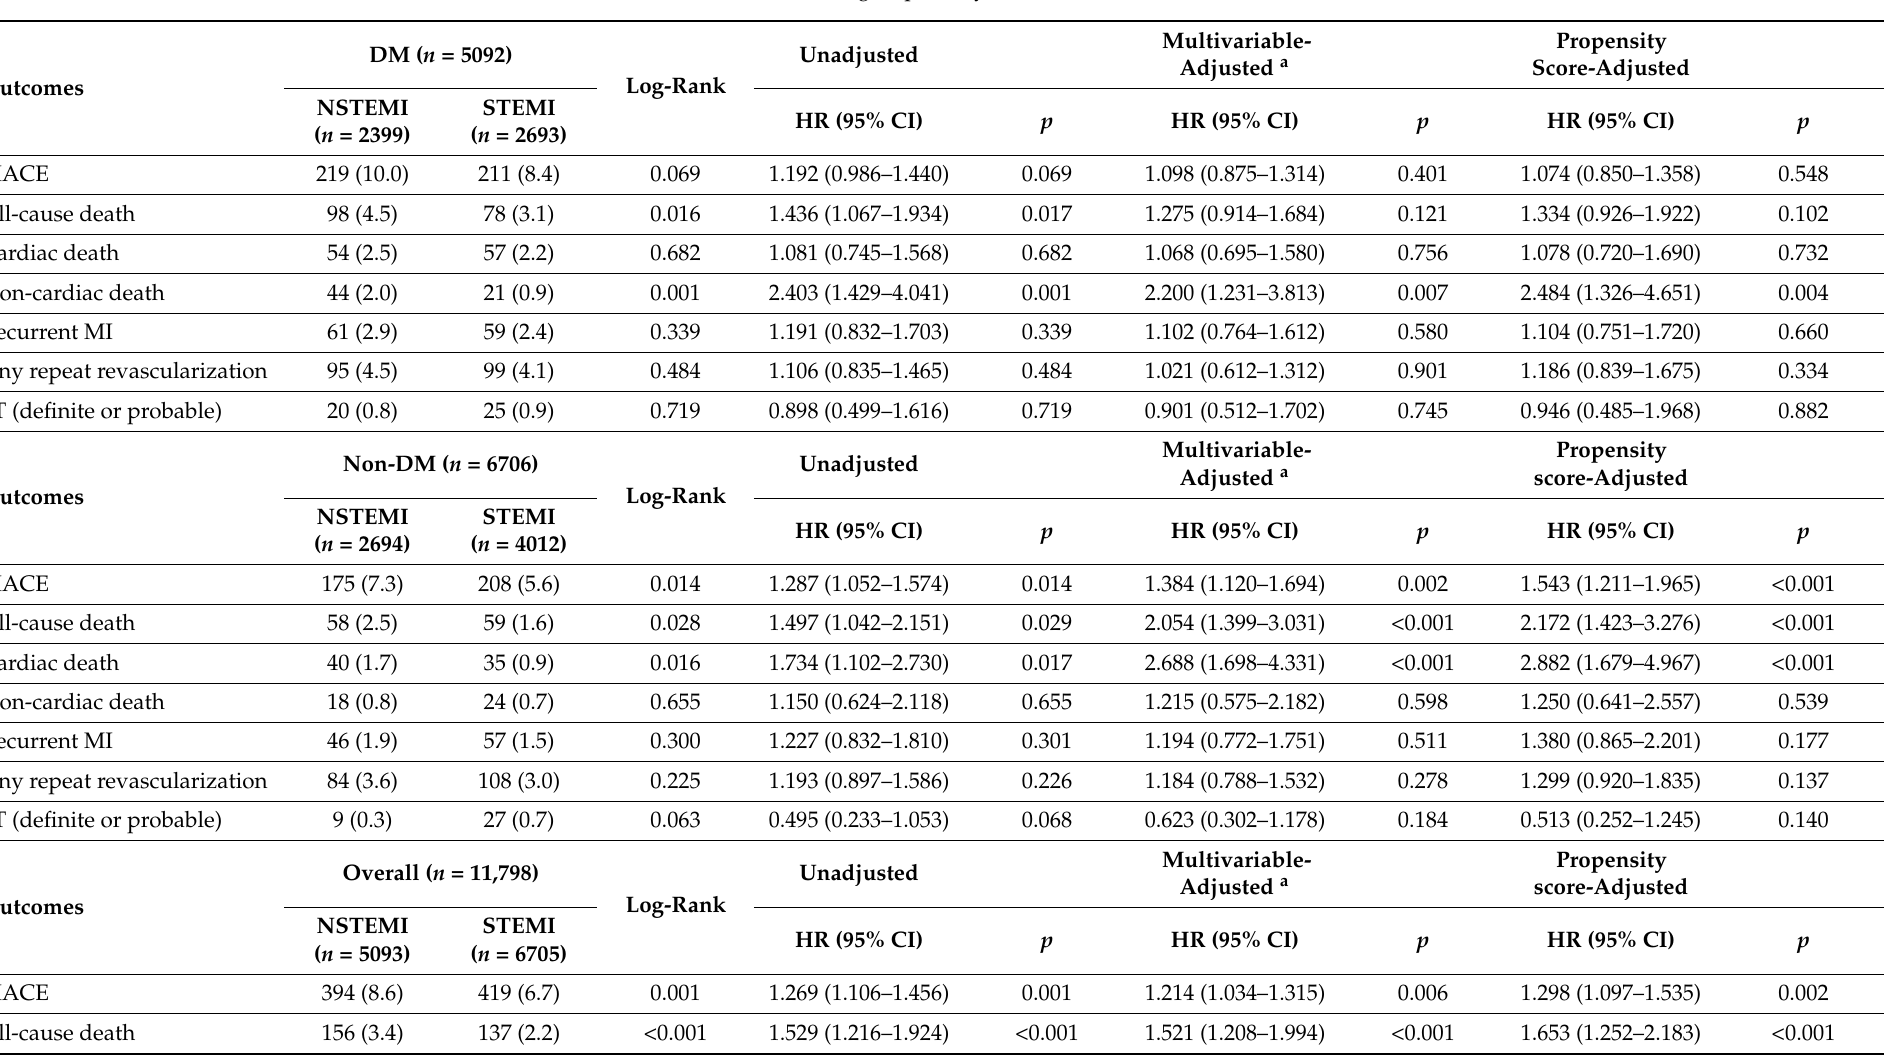
Table 2. Clinical outcomes between NSTEMI and STEMI groups at 2